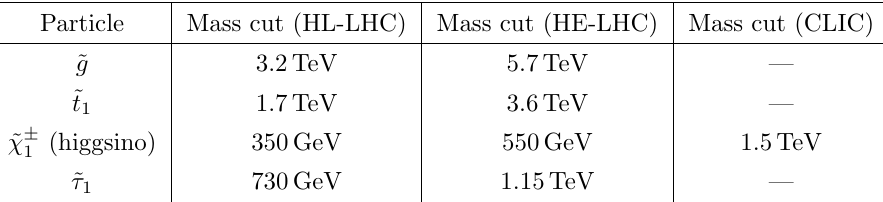
Table 1 . Exclusion potential of the HL-LHC, HE-LHC and CLIC on various SUSY particles as implemented in this analysis. The values for the HL-LHC and HE-LHC are taken from ref. [137]. For CLIC [138] we simply divided the optimal energy reach of 3 TeV by 2 as a baseline. (cid:15) The lightest Higgs boson is required to be in the mass range of 122 GeV (cid:20) m 128